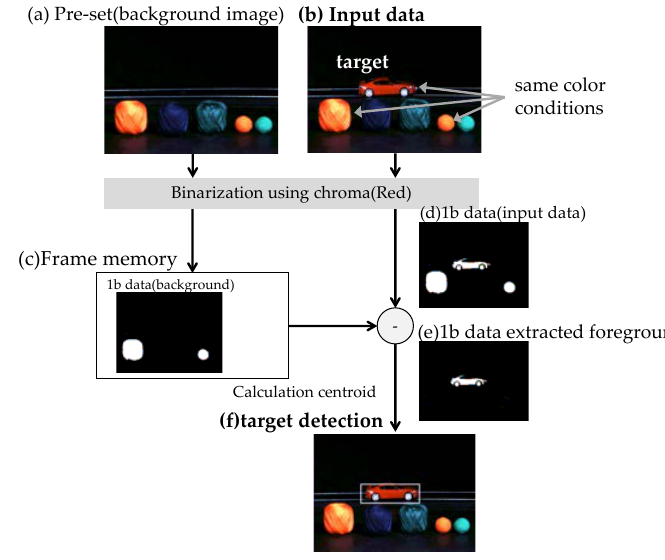
Figure 18. Background difference method using frame memory.